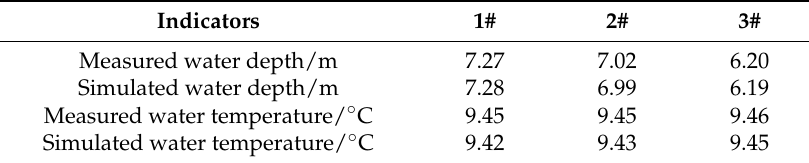
Table 1. Results of the model